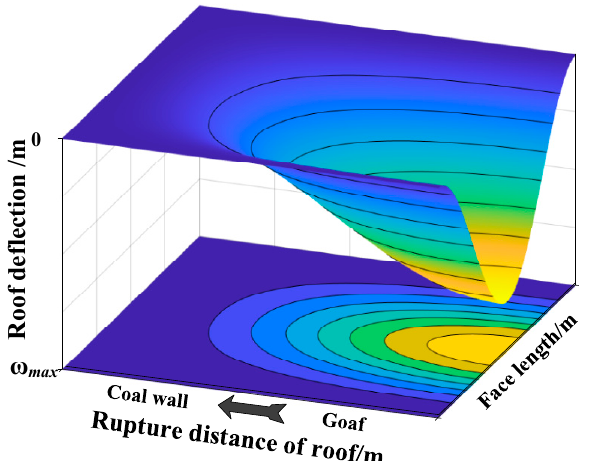
Figure 6. Roof deflection surface.